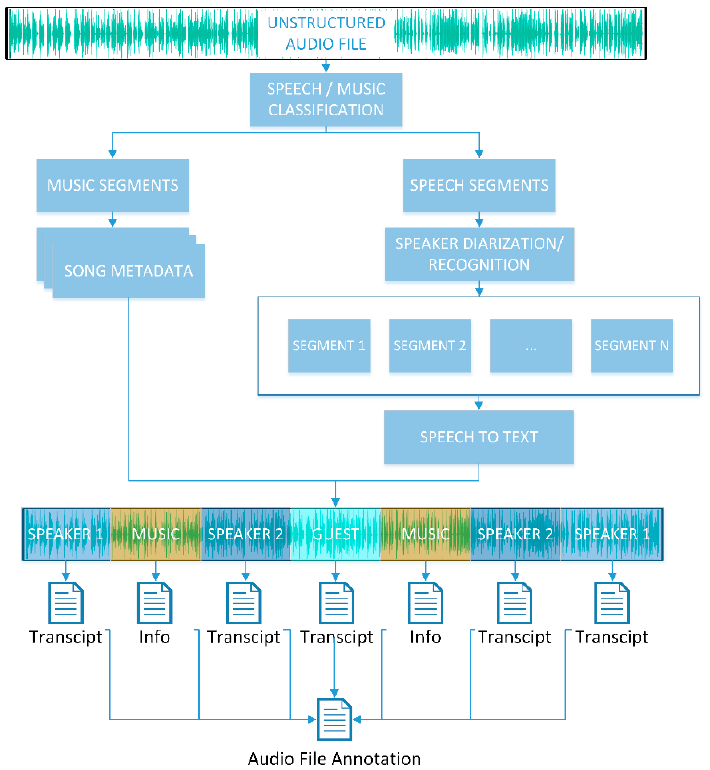
Figure 1. The proposed framework for podcast segmentation and knowledge extraction.